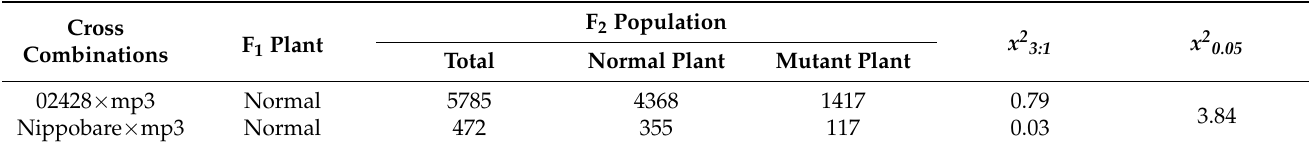
Table 3. Genetic analysis of the multi-pistil trait in mutant mp3.